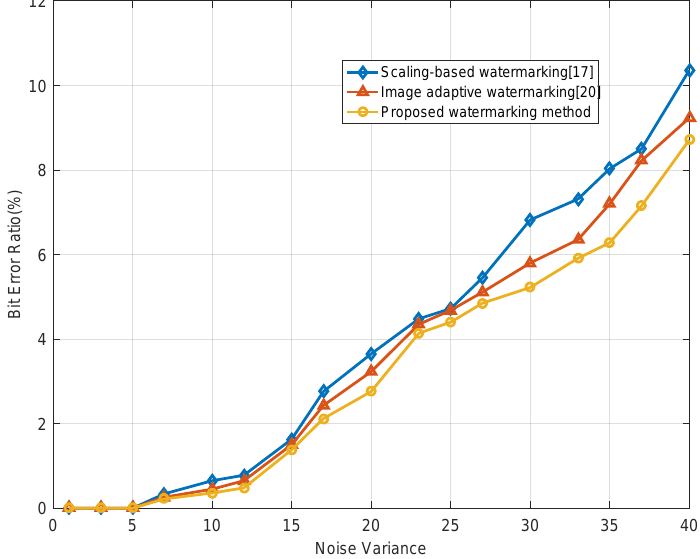
Figure 5. Performance comparison of various algorithms under noise attack.